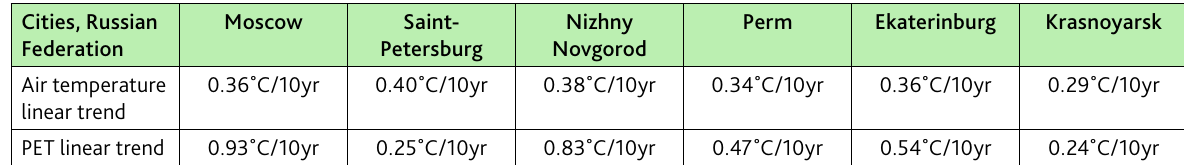
Table 2. Mean-Decade Trends for Air Temperature and for PET in different parts of Russian Federation in 1966-2015